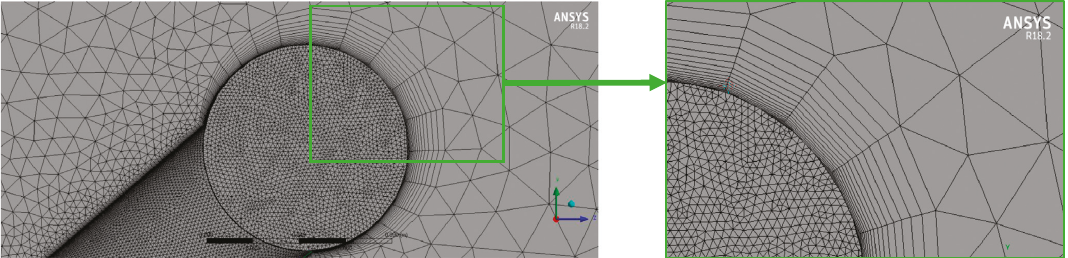
Figure 5: Mesh refinement around the pantograph elements.